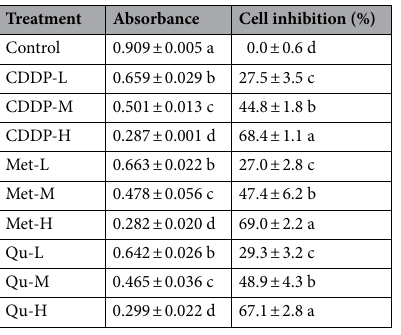
Table 1. The effect of single drug on Sune-1 cell proliferation.